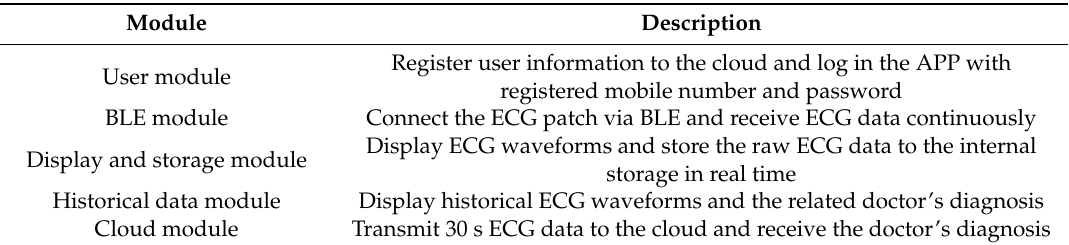
Table 1. Descriptions of the software modules of the APP.